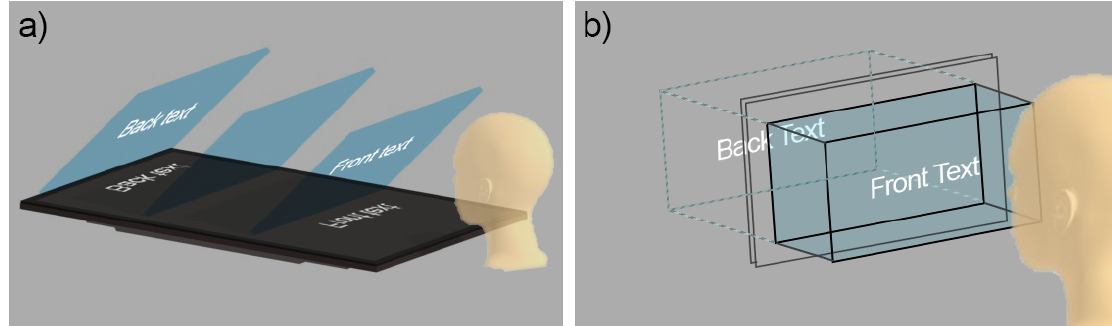
Figure 9. ( a ) Overlapped text readability task on SliceView with 316-mm of depth separation between sentences. ( b ) Overlapped text readability task on Looking Glass with 238-mm of virtual depth separation between sentences (physical depth of the device 98